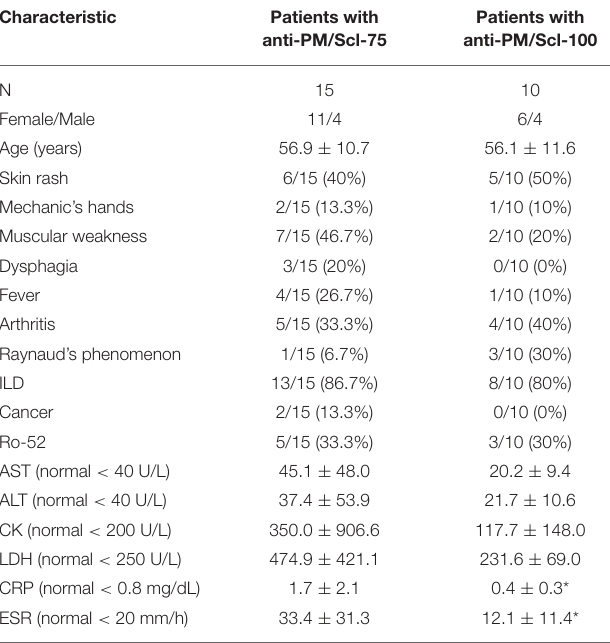
TABLE 1 | Differences between patients who tested positive for anti-PM/Scl-75 and anti-PM/Scl-100. Characteristic Patients with